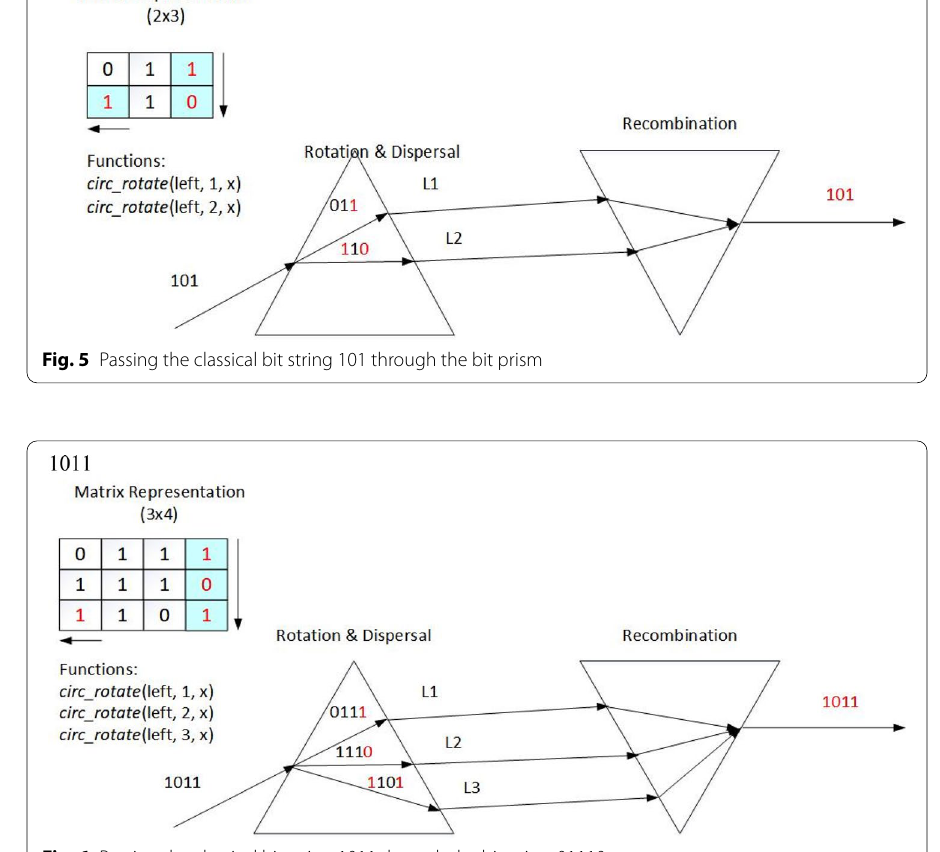
Fig. 6 Passing the classical bit string 1011 through the bit prism